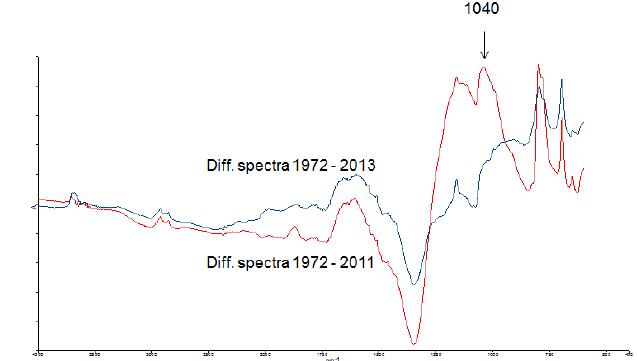
Figure 7. Differential FTIR spectra of the SS samples. SS 2011 spectra subtracted from the 1972 spectra (red line), and SS 2013 spectra subtracted from the 1972 spectra (blue